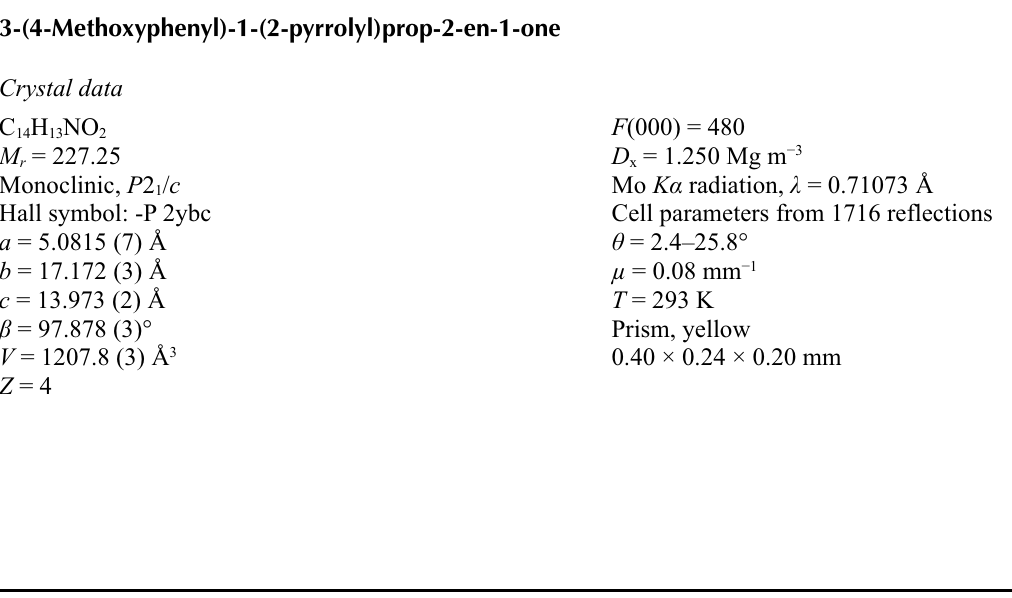
Packing diagram of the title structure showing the N—H···.O hydrogen bonding